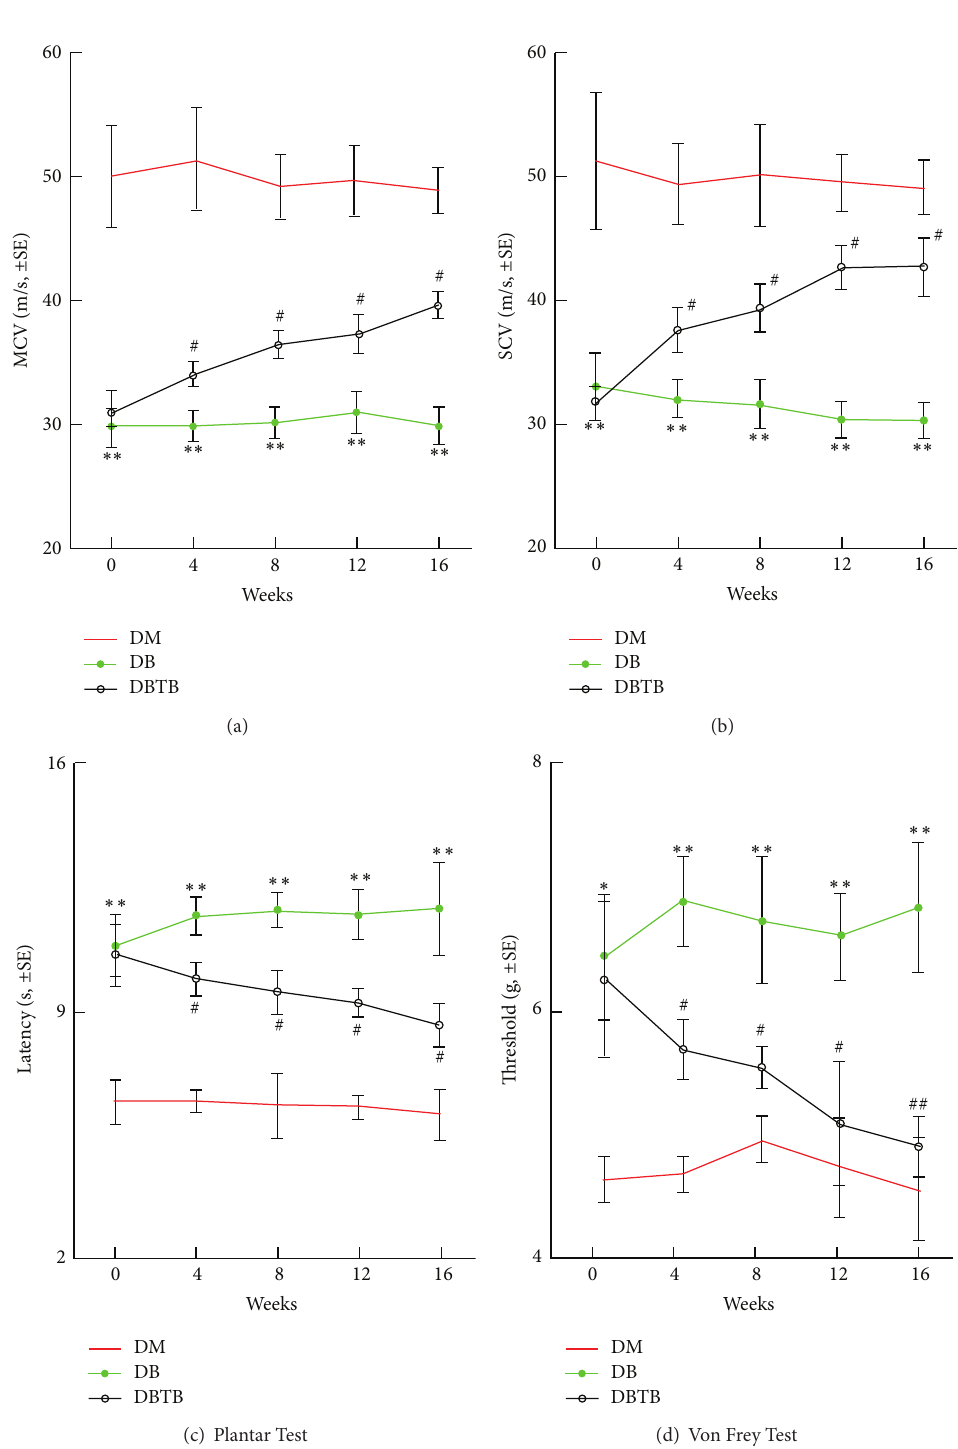
Figure 1: Effect of T 𝛽 4 on neurological function in diabetic mice. Treatment of diabetic mice with T 𝛽 4 improves neurological function measured by MCV (a), SCV (b), the Plantar test (c), and von Frey test (d). ∗ 𝑃 < 0.05 , ∗∗ 𝑃 < 0.01 versus the nondiabetic group (DM). # 𝑃 < 0.05 and ## 𝑃 < 0.01 versus the diabetic group (DB) treated with saline. 𝑛 = 10